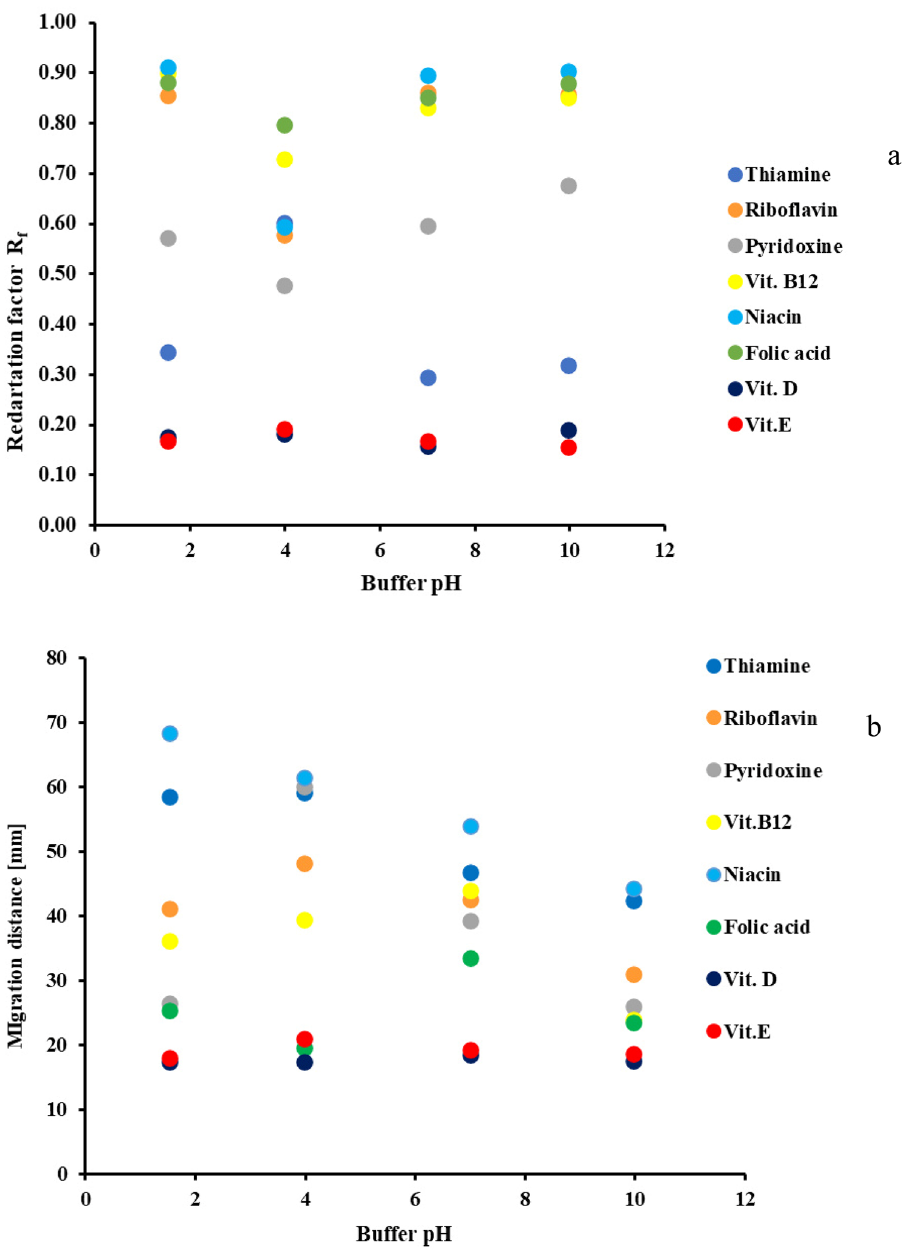
Figure 2. The effect of buffer pH on the investigated vitamins: ( a ) retention (in TLC) and ( b ) migration distance (in PPEC). The mobile phase composition was acetonitrile 50% v / v aqueous buffer (acetic acid. phosphoric acid and boric acid (4–2.22 mM each) and sodium hydroxide (0–8.86 mM)), as well as 18.75 mM of SDS. For TLC, the distant migration of the eluent front was 45 mm, the temperature was ambient (25 °C). For PPEC, experiment time was 8 min., polarisation voltage was 800 V, temperature was 23